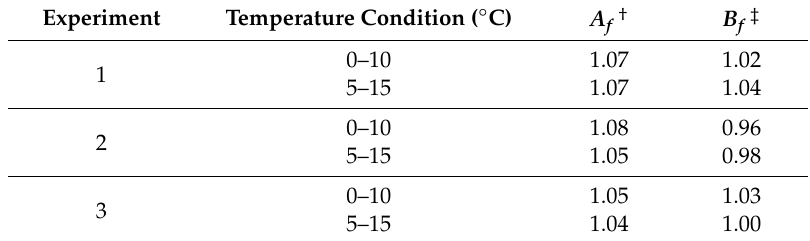
Figure 9. Comparison of measured acidity variation and predictions of the model with the assumption of N max = N max ( T MKT ) for experiments 1–3. Table 6. Comparison of accuracy and bias factors of the predictive models using the assumption of N max = N max ( T MKT ) for experiments 1–3.